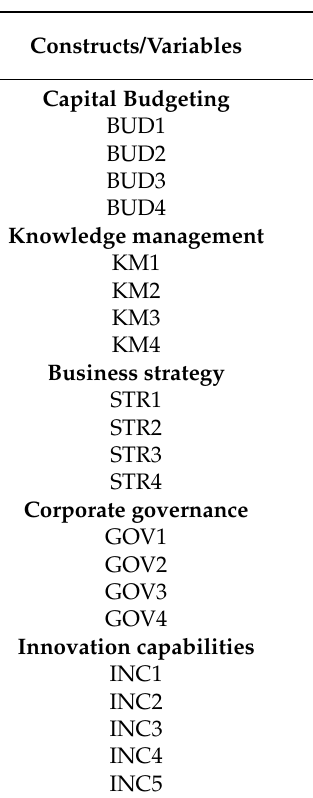
Table 2. The reliability and convergent validity.